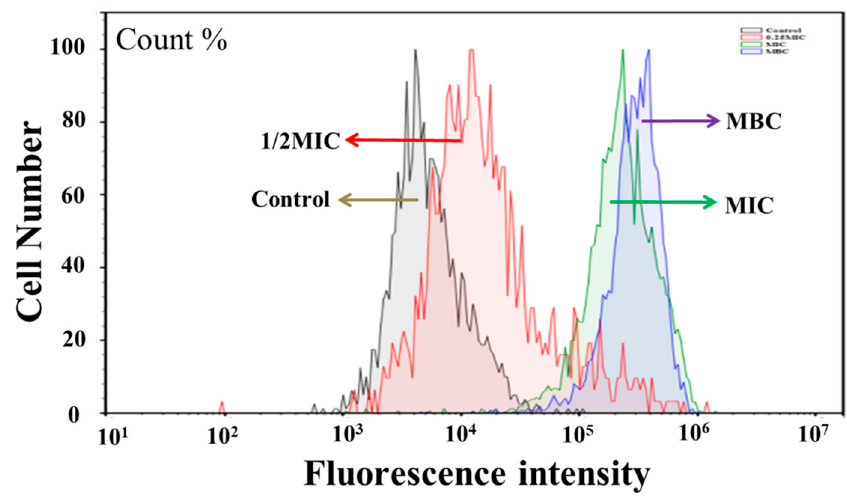
Figure 6. Effect of juglone on the ROS content of P. aeruginosa .